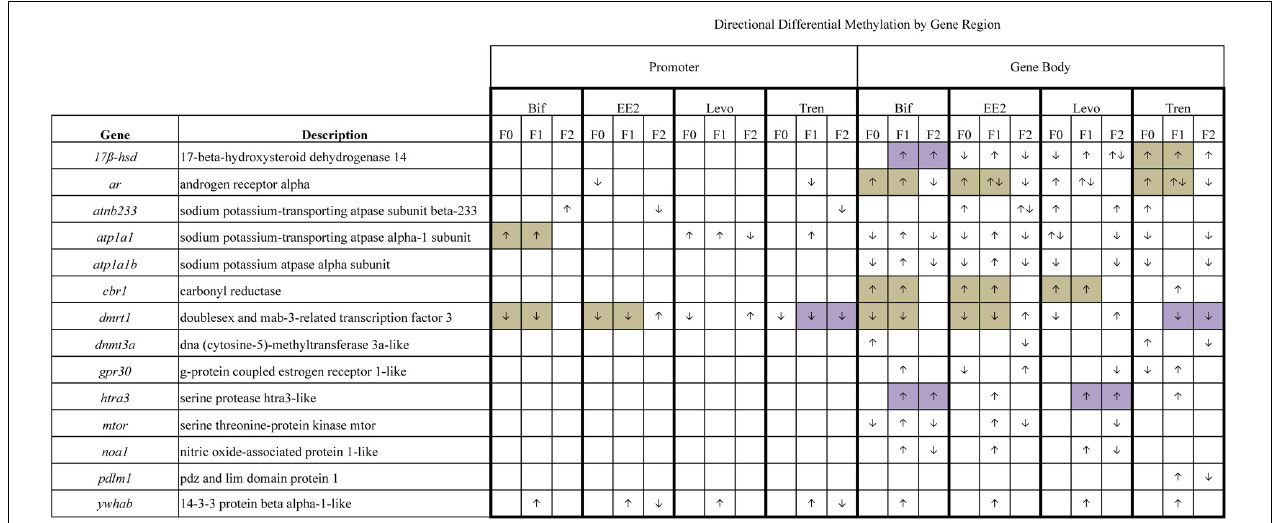
FIGURE 6 | Potential endocrine disrupting compound-responsive genes (EDCRGs) with differential methylation across more than one generation within the same treatment (Bif, EE2, Levo, Tren) relative to the control in Supplementary Table S1 . Arrows indicate the change in methylation relative to the control ( ↑ is hypermethylation; ↓ is hypomethylation) in the gene region indicated (promoter or gene body). In instances for which both hyper- and hypo-methylation were noted for different loci in the same gene region, both arrows are indicated ( ↑↓ ). A change in methylation in F1 animals indicates a multigenerational effect, while a change in methylation in F2 animals indicates a transgenerational effect of EDC exposure. Methylation changes are shaded in tan the same locus that was differentially methylated across the F0 and F1 generations, indicating identical effects occurring from exposure in both generations or potentially a multigenerational inheritance pattern. Purple shading indicates the maintenance of specific methylation direction and loci from an exposed generation (F1) to an unexposed generation (F2) in support of transgenerational epigenetic